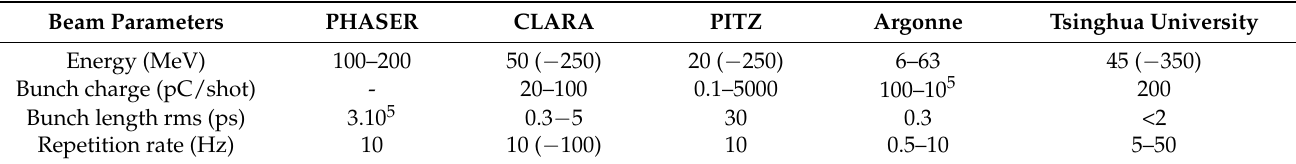
Table 2. List of facilities or accelerators under development for VHEE